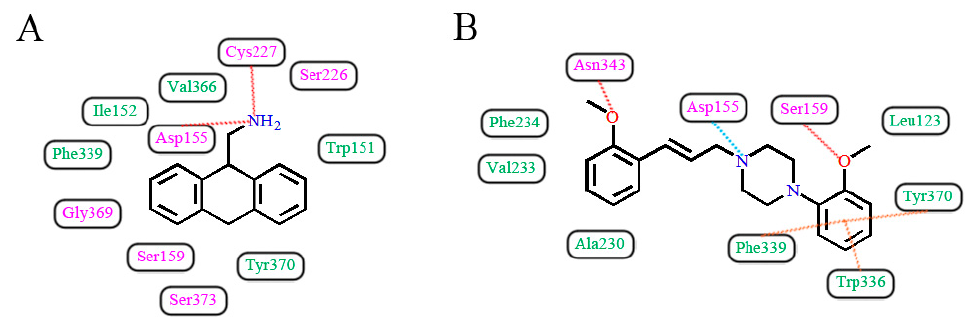
Figure 12. Two docking modes in the 5-HT 2A receptor. ( A ) AMDA [40]; ( B ) Antagonist 12 [43]. H-bond, π - π stacking and salt bridge interactions are observed as red, orange and blue dashed lines, respectively. Hydrophobic and hydrophilic residues are respectively displayed as green and purple words.